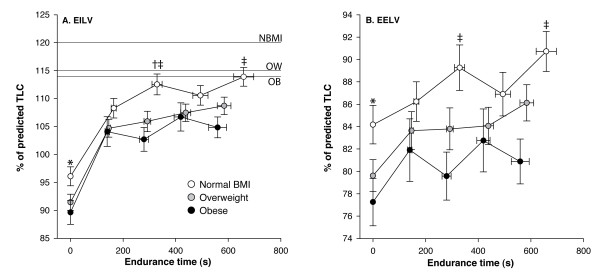
Operating lung volumes during constant workrate cycle exercise expressed as a % of predicted total lung capacity according to body mass index categories. Panel A shows end-inspiratory lung volume (EILV) and panel B, end-expiratory lung volume (EELV). Data points represent mean values at baseline, 25%, 50%, 75% and 100% of constant workrate endurance time. Values are mean ± SE. White filled circles are normal BMI, grey are overweight and black, obese patients. Horizontal lines represent total lung capacity for normal BMI (NBMI), overweight, (OW) and obese (OB) patients. * = p < 0.05; † = p < 0.005; ‡ = p < 0.01.